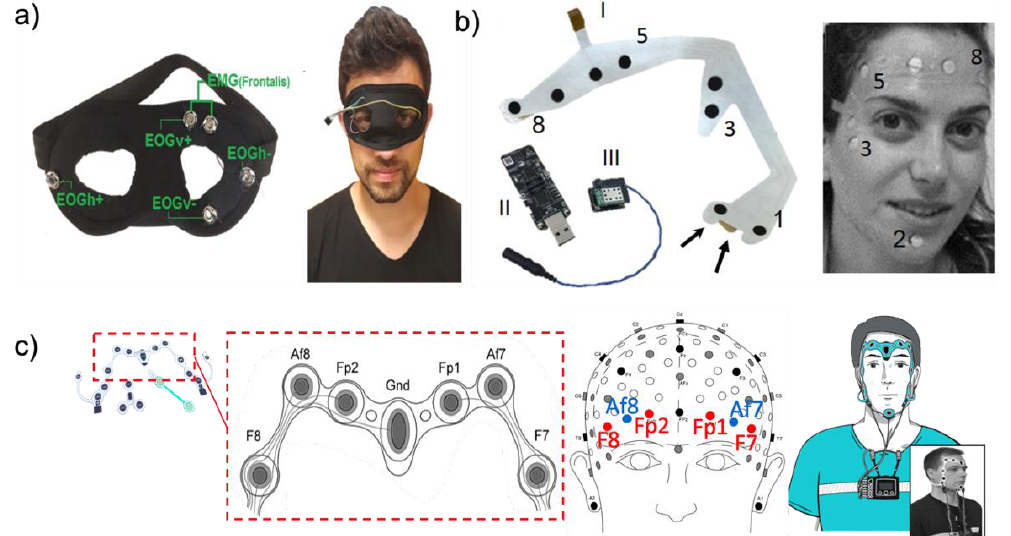
Figure 6. Examples of facemask platforms for EOG monitoring. ( a ) Face type of EOG device with graphene-coated tissue electrodes (reprinted under terms of the CC-BY license [42]. Copyright 2019, the Authors. Published by JAIC). ( b ) The electrode array system and a subject wearing a temporary- tattoo eight-electrode array (reprinted with permission [41]. Copyright 2019 IOP). ( c ) Positions of a screen-printed electrode set and a subject wearing screen-printed electrodes (reprinted with permission [7]. Copyright 2019